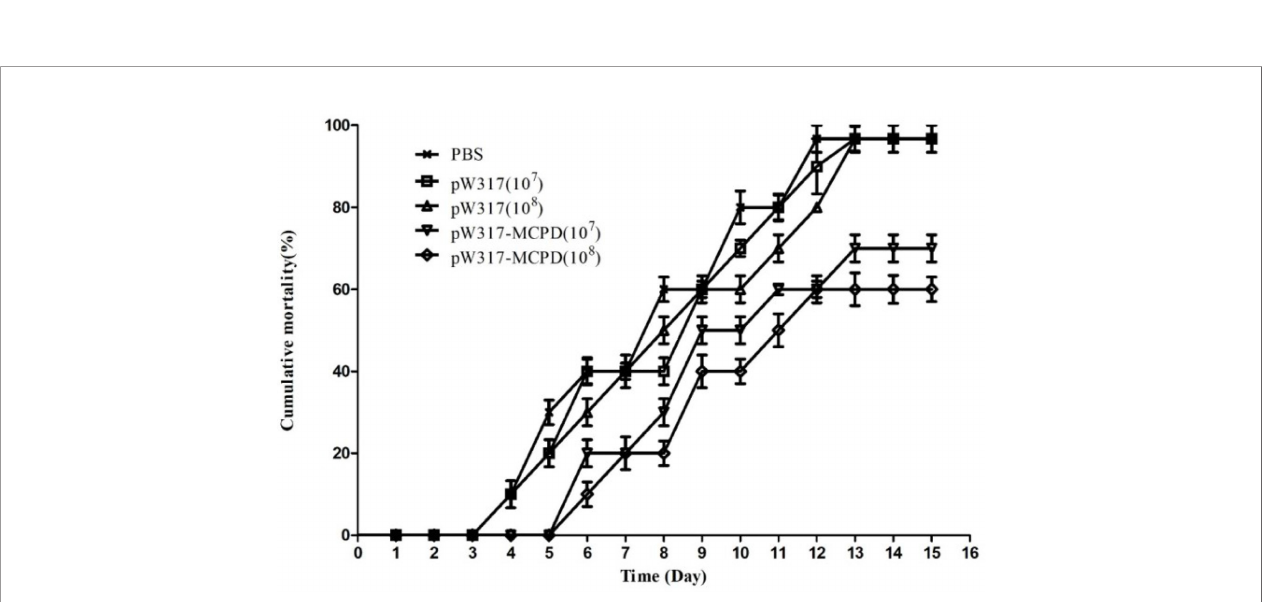
FIGURE 9 | The cumulative mortality of vaccinated largemouth bass. Note: 10 7 pW317: 10 7 CFU/g GS115-pW317; 10 8 pW317: 10 8 CFU/g GS115-pW317; 10 7 pW317-MCPD: 10 7 CFU/g GS115-pW317-MCPD; 10 8 pW317-MCPD: 10 8 CFU/g GS115-pW317-MCPD.